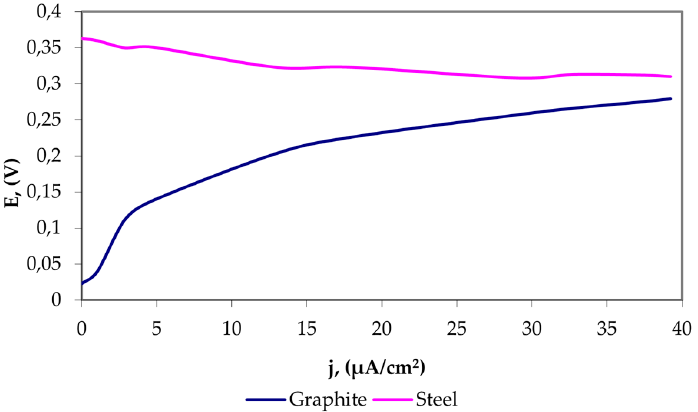
Figure 8. Corrosion diagram of a steel sample with phosphate coating from a solution with the addition of calcium nitrate.